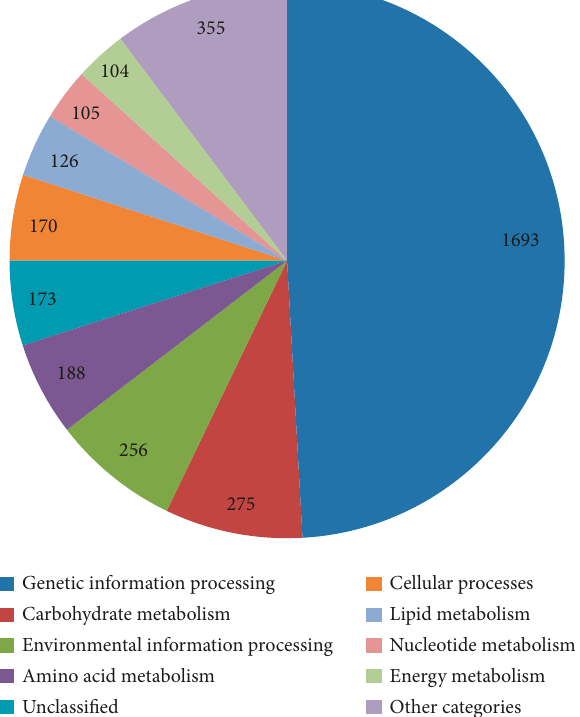
Figure 3: Classification of S. latifolia proteins by the Kyoto Encyclopedia of Genes and Genomes (KEGG) database.